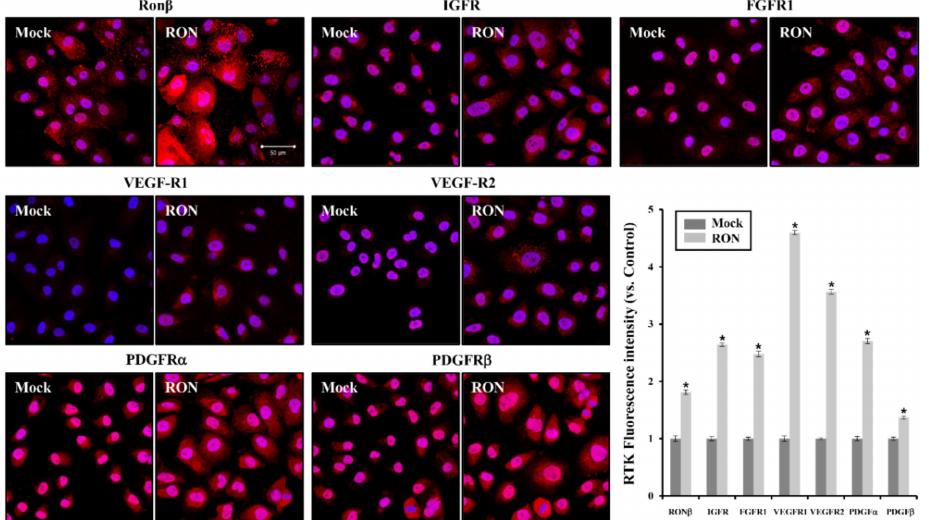
Figure 4. Expression of RTKs by RON overexpression in HK-2 cells. Immunofluorescence of RON, IGFR, FGFR1, VEGFR1, VEGFR2, PDGFR α , and PDGFR β by RON overexpression was evaluated using fluorescence microscopy. The overexpression of RON (red) significantly increased other RTKs. The nucleus (blue) was stained with DAPI. (magnification, 400 × ; bar = 50 µ m) * p < 0.05, compared with the